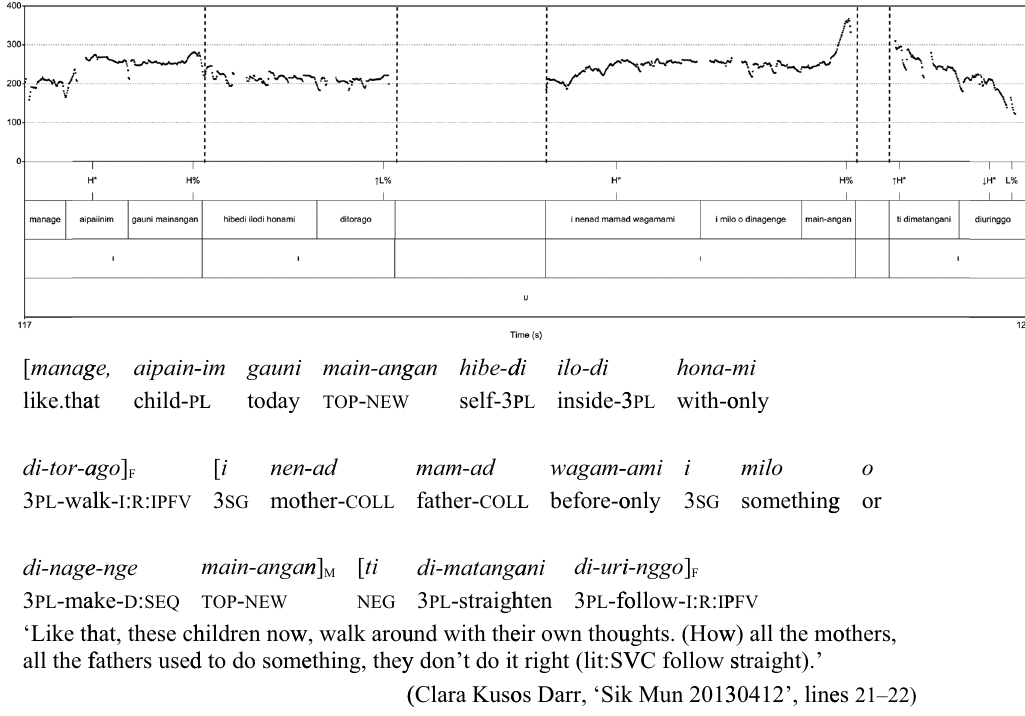
Figure 9: Final clause that is not prosodically fi